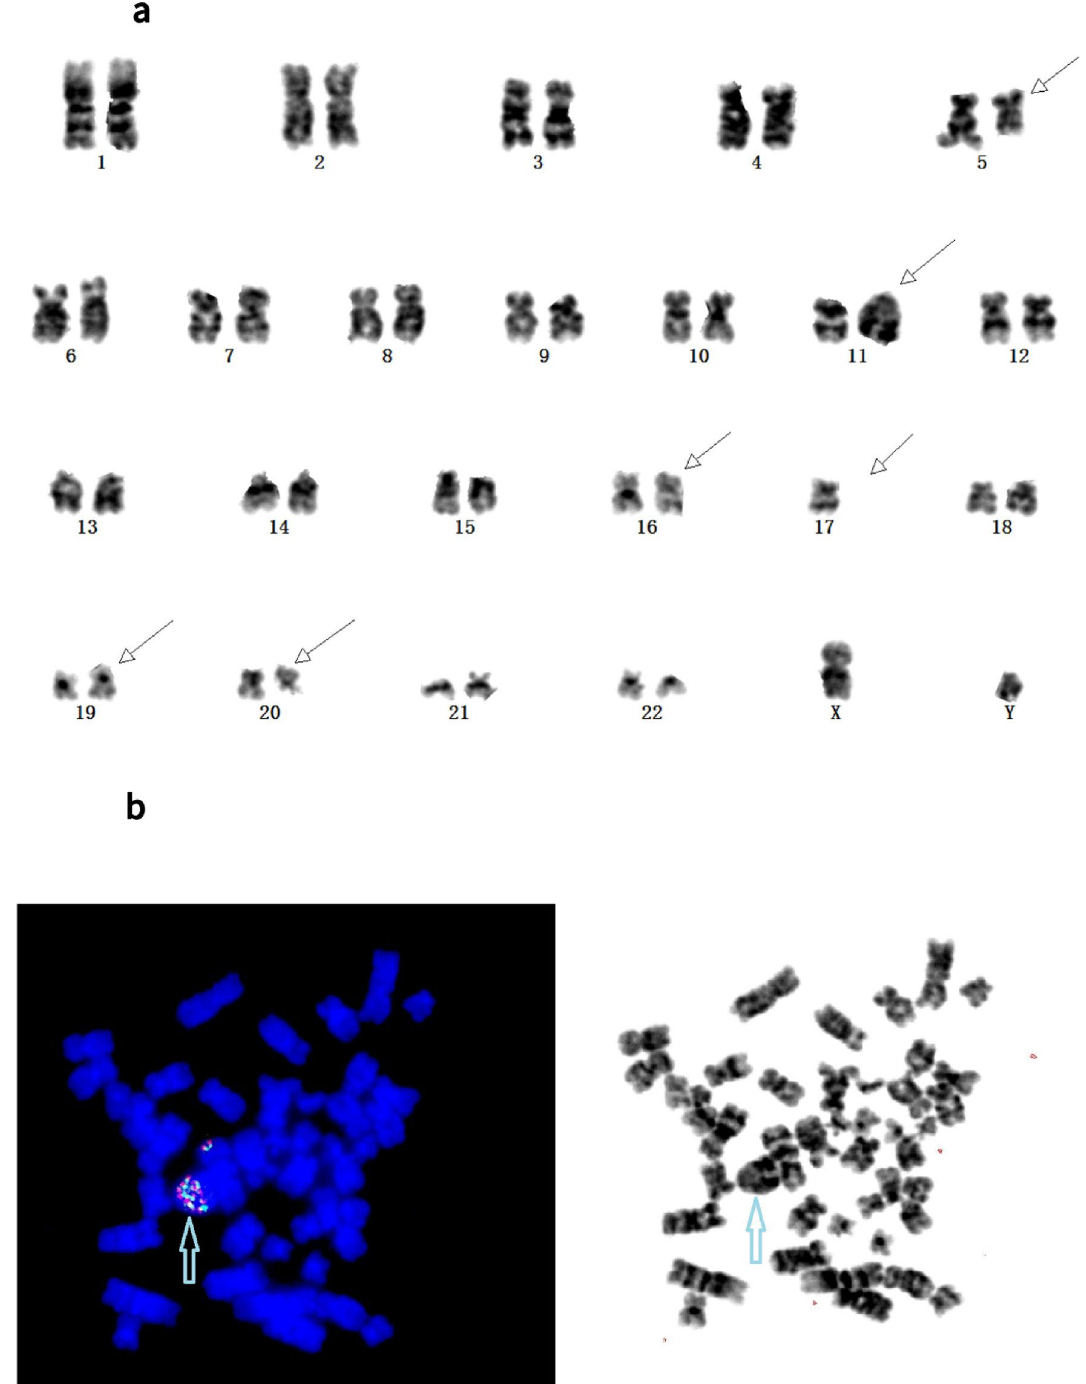
Figure 1. ( a ) Chromosome banding analysis of patient 25 showing a complex karyotype: 45,XY,del(5) (q13q32),del(11)qdp(11)(q21q23)r(11)(p15;q25),der(16;17)(p10;q10),add(19)(q13),del(20)(q11). ( b ) Fluorescence in situ hybridization (FISH) analysis of Patient 25 using the KMT2A probe revealed multiple KMT2A fusion signals present on derivative chromosome 11 (blue